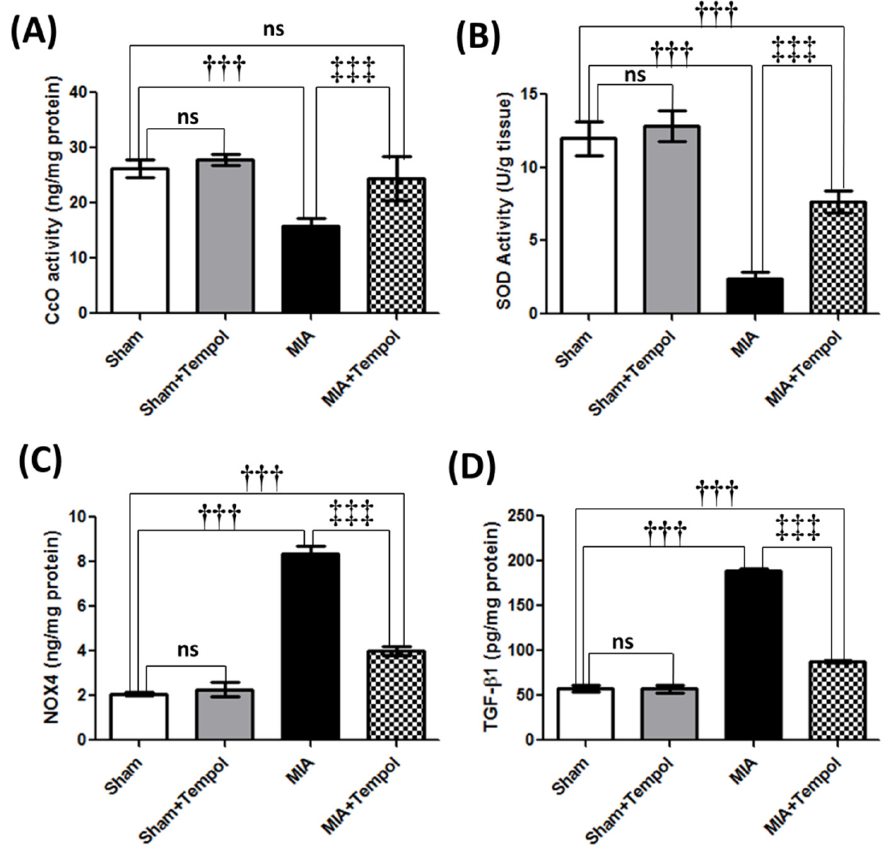
Figure 4. Effect of Tempol on Complex IV oxidase and oxidative stress on osteoarthiritic rats. Rats intra-articular injection of 3 mg MIA/50 µ L saline in their right knees, and then tempol was administered starting from the 7th day of the experiment in a dose of (100 mg/kg/day) by oral gavage for 21 consecutive days. Values of ( A ) Tissue contents of cytochrome c oxidase (CcO) or Complex IV, ( B ) Tissue contents of superoxide dismutase (SOD), ( C ) Tissue contents of NADPH oxidase 4 (NOX4), and ( D ) Tissue contents of transforming growth factor– β 1 (TGF- β 1). Statistical analysis was carried out using one-way ANOVA followed by Tukey’s multiple comparison test. Results are expressed as mean ± SD ( n = 6). ††† p < 0.001 vs. the sham group, and ‡‡‡ p < 0.001 vs. MIA